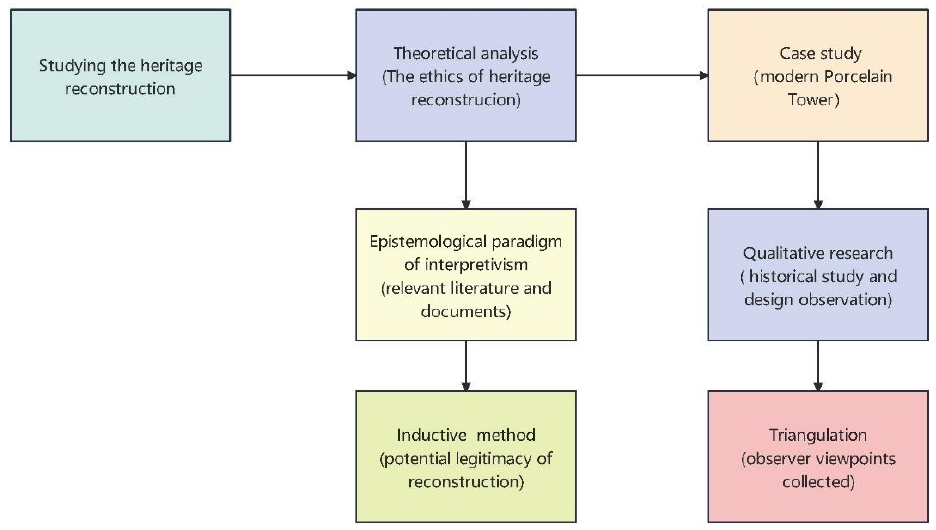
Figure 1. The methodology adopted in the research (Source: by the authors).